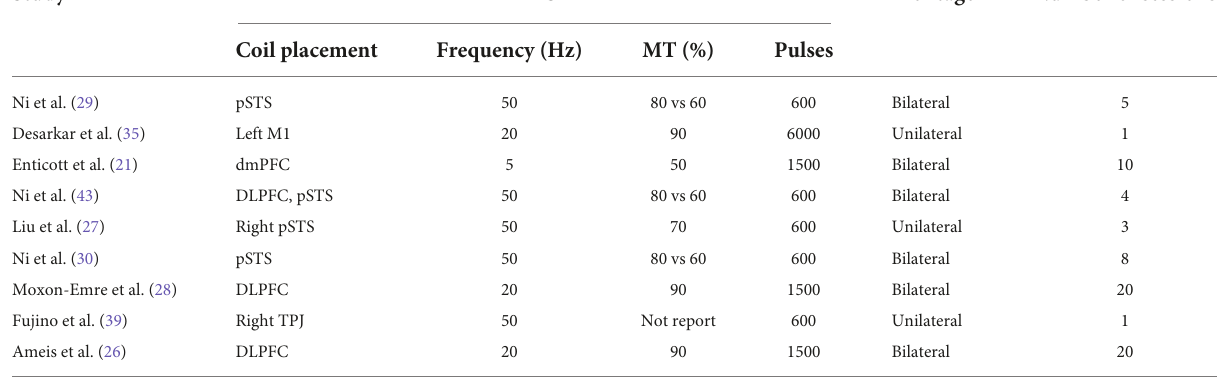
TABLE 3 Stimulation parameters for transcranial magnetic stimulation